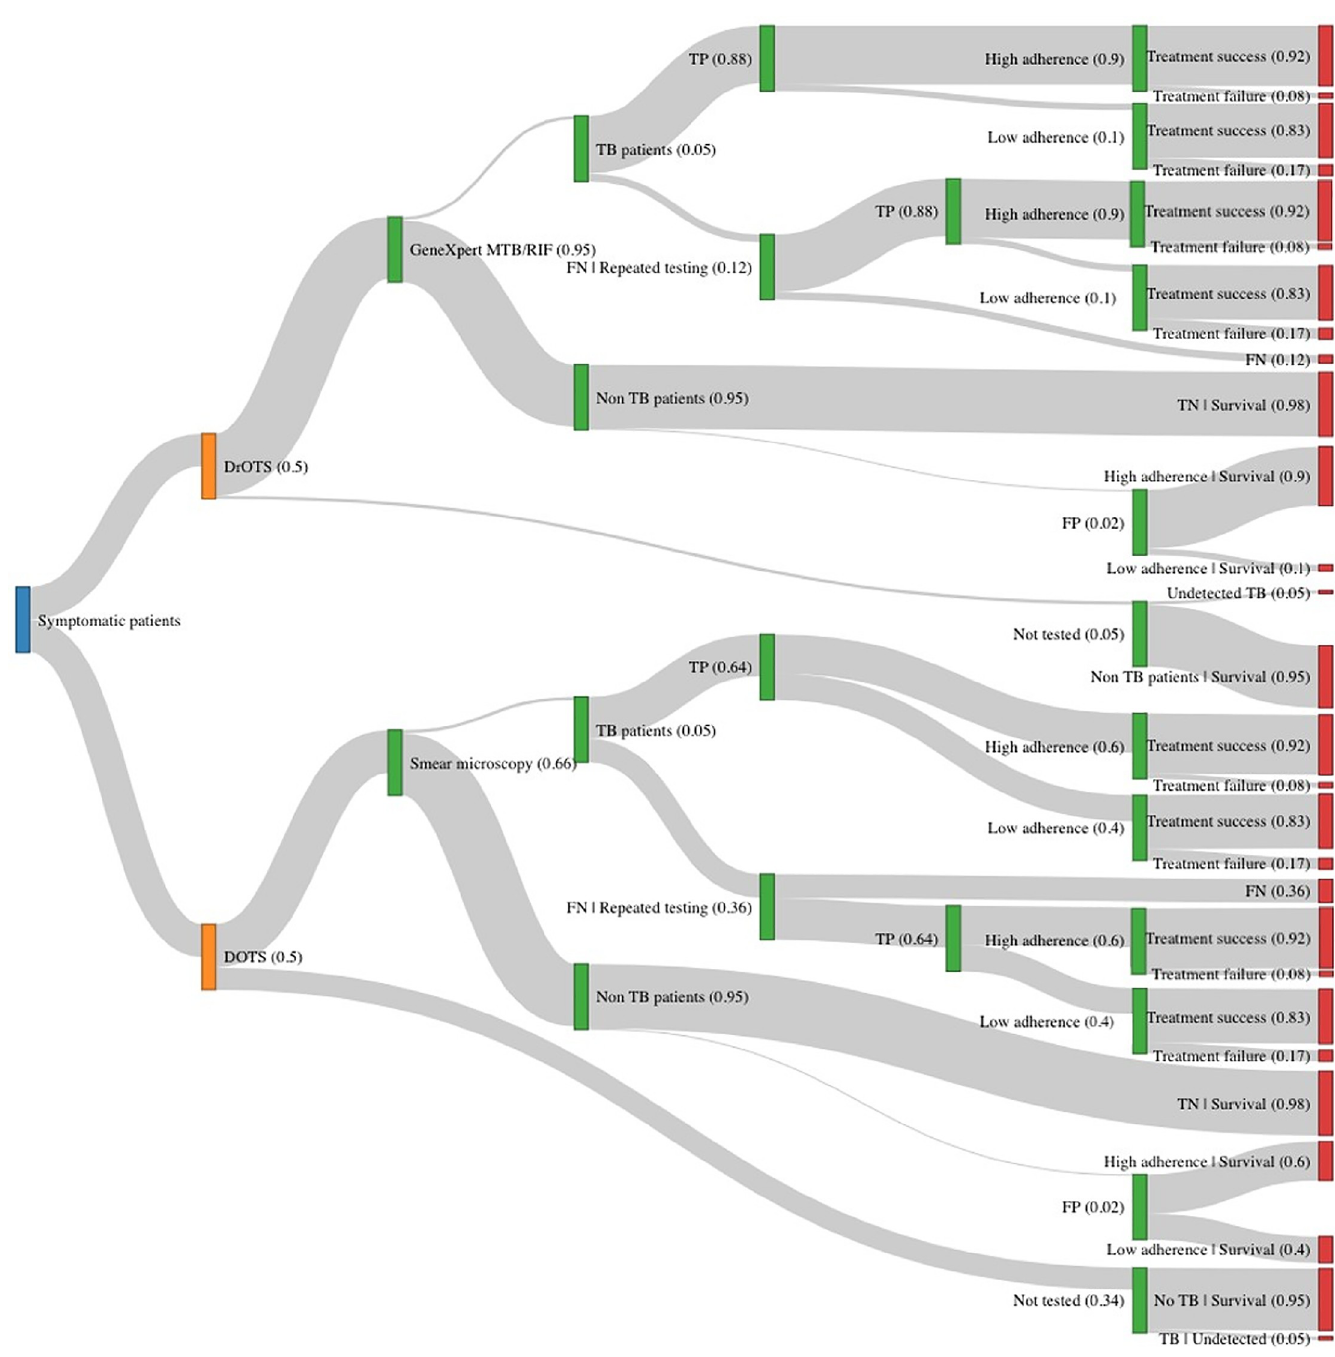
Fig 2. Decision tree analysis model. Decision tree analysis model comparing both strategies and presenting the study population (blue), TB control strategies (orange), decision nodes (green) and outcomes (red). Model arms width are proportional to probability scores described in text. DOTS; Directly Observed Therapy, DrOTS; Drone Observed Therapy System, FN; False negatives, FP; False positives, TN; True negatives, TB; Tuberculosis, TP; True positives.